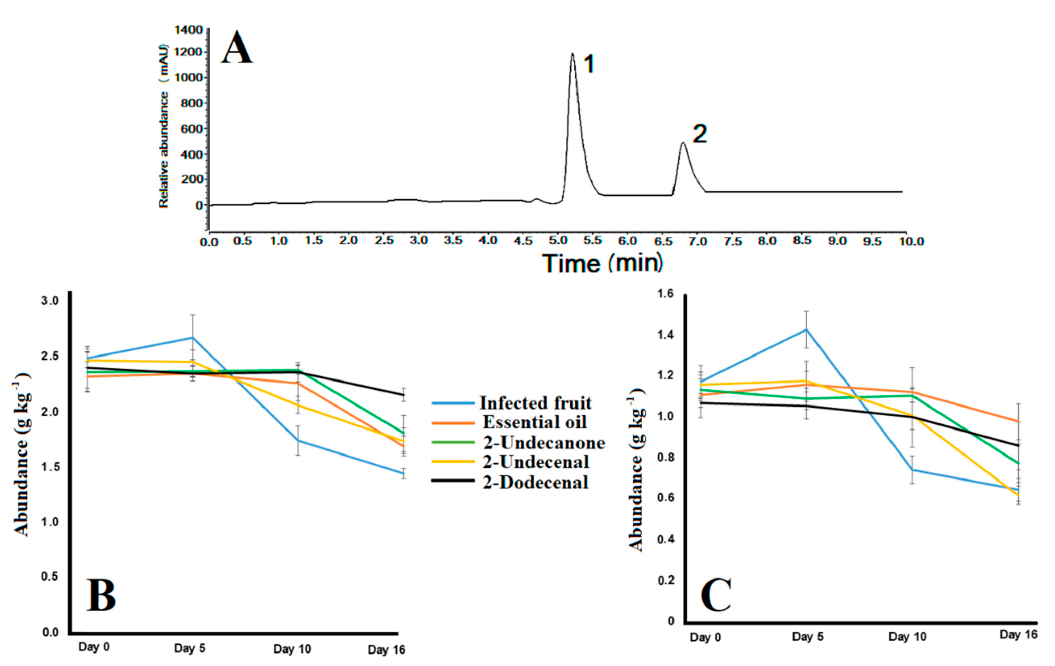
Figure 7. Protective effect of 120 mg L − 1 ZlEO, 150 mg L − 1 2-undecanone, 220 mg L − 1 2-undecenal,